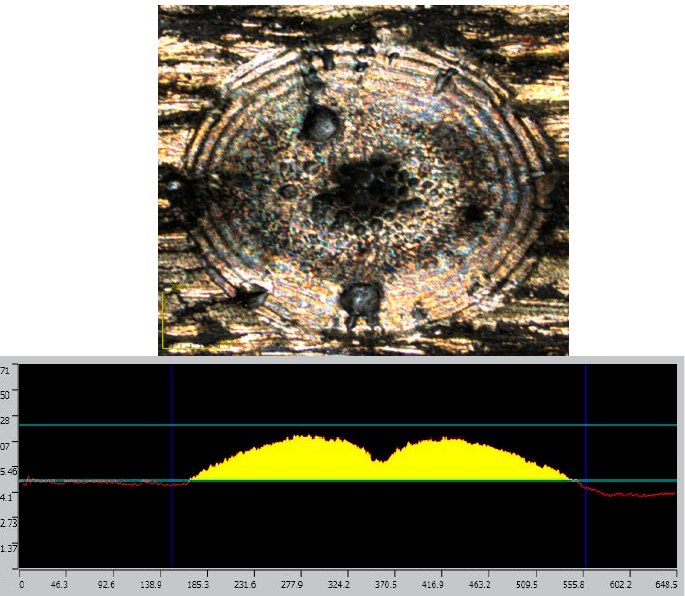
Figure 2. Photograph and view of the formation profile along the tube resulting from exposure to a